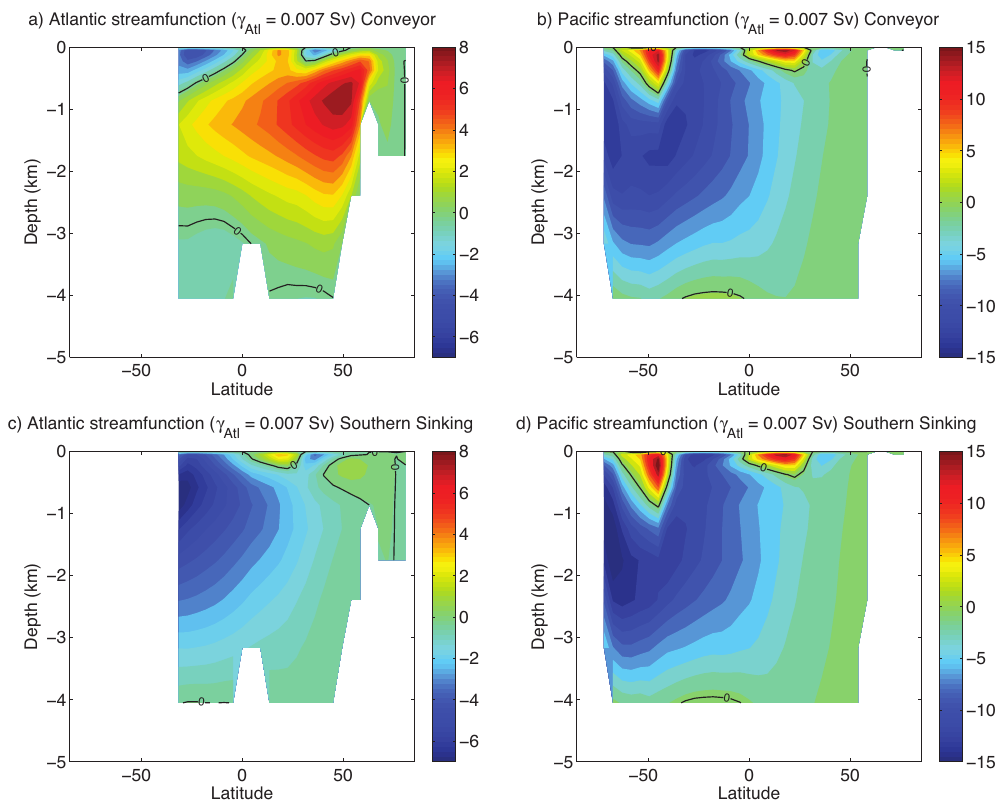
Fig. 9. Atlantic and Pacific meridional overturning streamfunctions in case RETRO2. Because the reference state is very close the saddle-node bifurcation point on the lower branch, the circulation is shown for γ Atl =0.007Sv (see also Fig. 8 and Sect. 4.2), a small freshwater perturbation in the North Atlantic. (a) and (b) give the Conveyor-like solution, with positive overturning in the Atlantic and upwelling in the Pacific. (c) and (d) show the Southern Sinking solution with an upwelling cell in both basins. Because the subpolar North Atlantic is fresher in RETRO2, the bifurcation diagram has shifted to the right, compared to the bifurcation diagram for